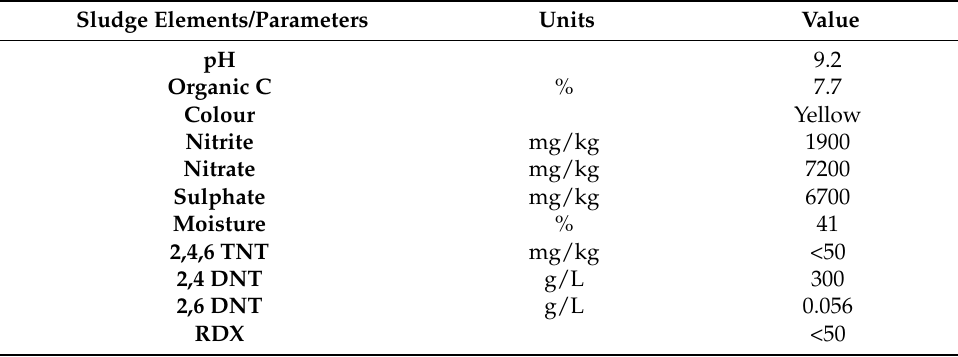
Table 1. Physical and chemical characteristics of the sludge used in this study.